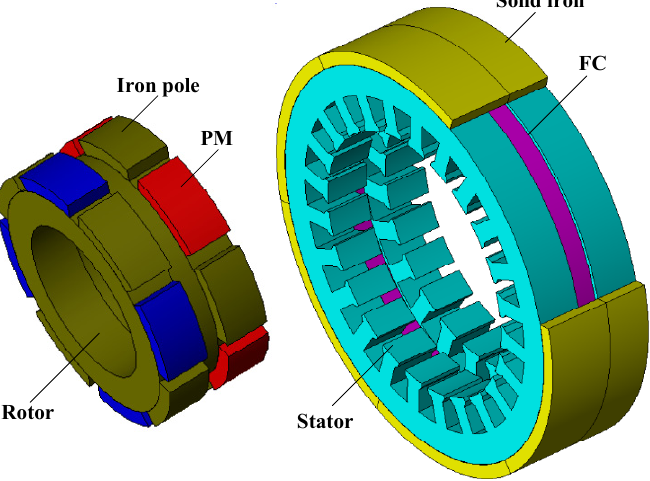
Figure 3. Configuration of a mixed ‐ excited HE machine with a toroid FW in stator yoke [27].